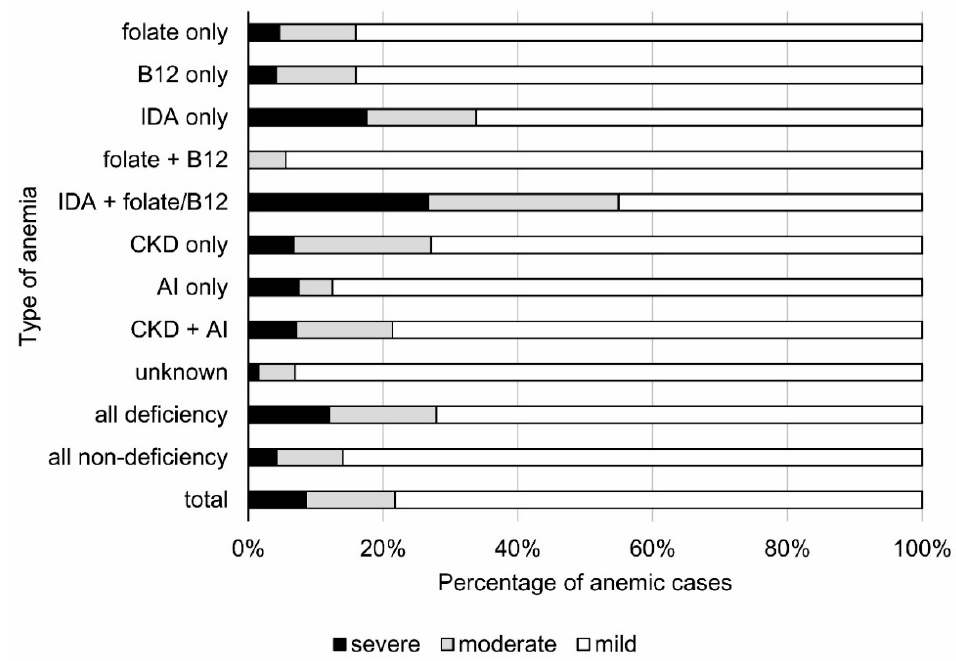
Figure 3. The proportion between severe (hemoglobin—Hb < 10 g/dL), moderate (Hb: 10–11 g/dL), and mild anemia in defined types of anemia (classified according to receiver operating characteristic curve analysis) in the PolSenior study. AI—anemia of inflammation; CKD—chronic kidney disease; IDA—iron deficiency anemia.